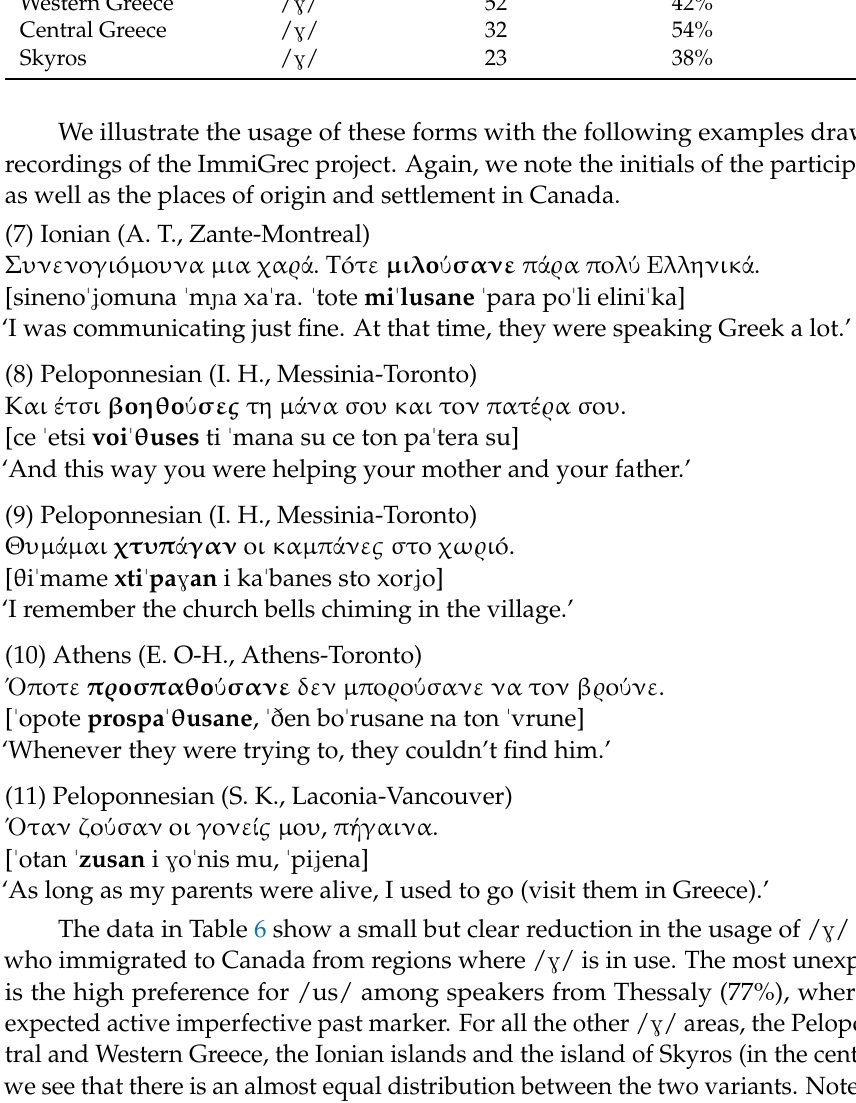
Table 6. Distribution of the /us/ variant among CG speakers by region of origin (N = 1504). Region Expected /us/ (N) /us/ (%) Total N Athens both 98 56% 175 Ionian islands / G / 136 46% 296 Lesbos /us/ 31 94%